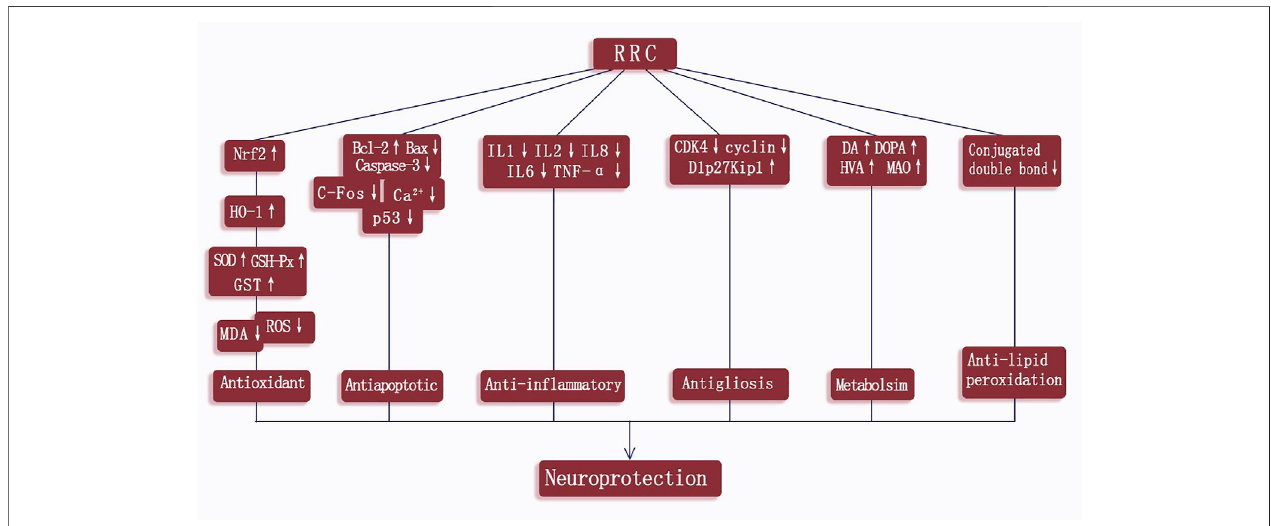
FIGURE 10 | A schematic representation of neuroprotection mechanisms of RRC for ischemic cerebral injury.